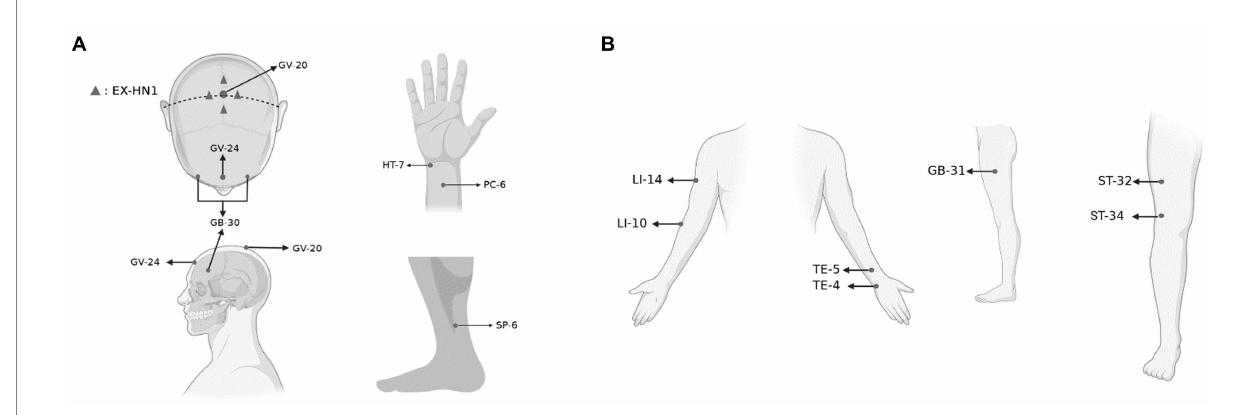
FIGURE 1 The acupoints selected in the trial. (A) The acupoints selected in the RA group and (B) the acupoints selected in the SA group. Created with